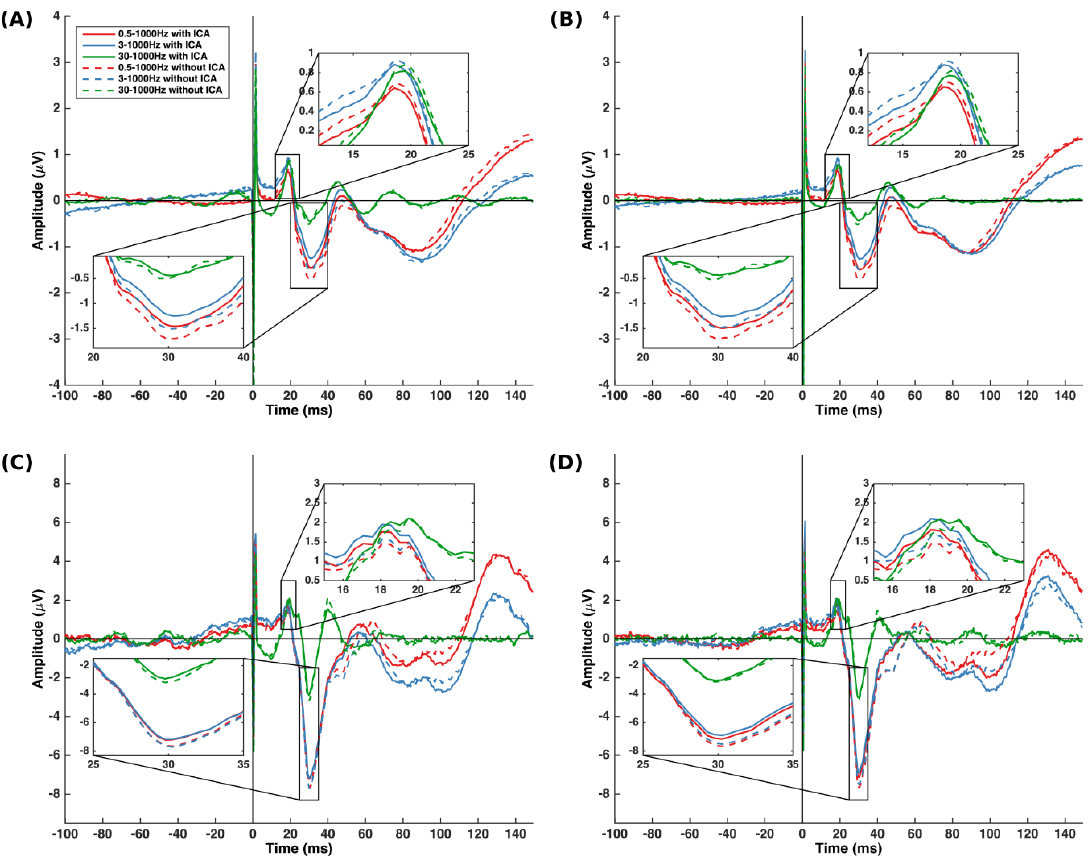
Figure 3. SEPs. Grand average SEPs filtered with ( A ) FIR and ( B ) IIR. Mean SEPs from one session of a representative participant processed with ( C ) FIR and ( D ) IIR filter.